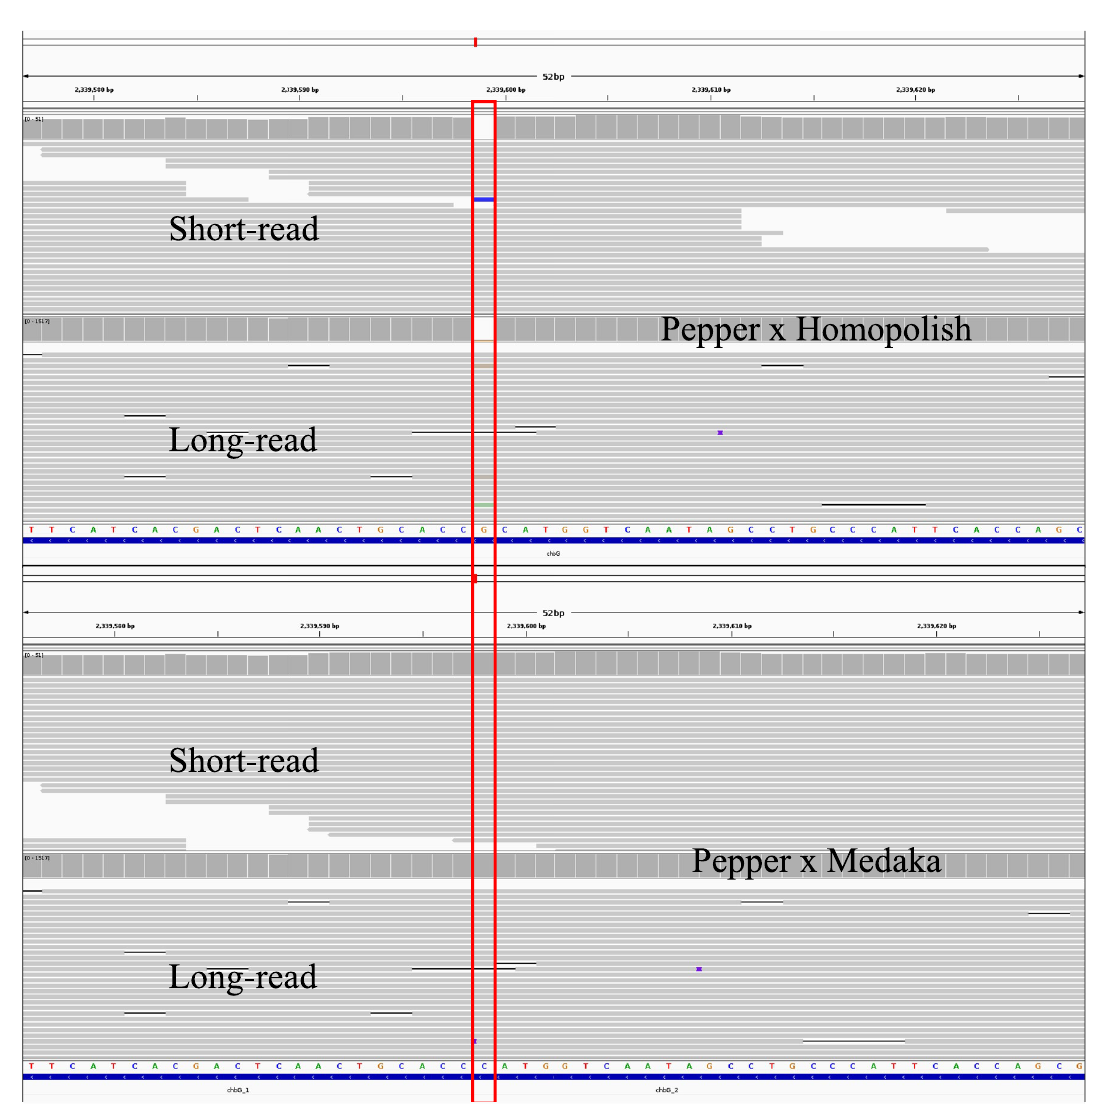
Figure 6. Visualized read alignment to the polished genome using IGV. Polished genome using Homopolish did not contain the sample-specific variation, however, read-based polishing PEPPER × Medaka polishing successfully reflect the sample-specific